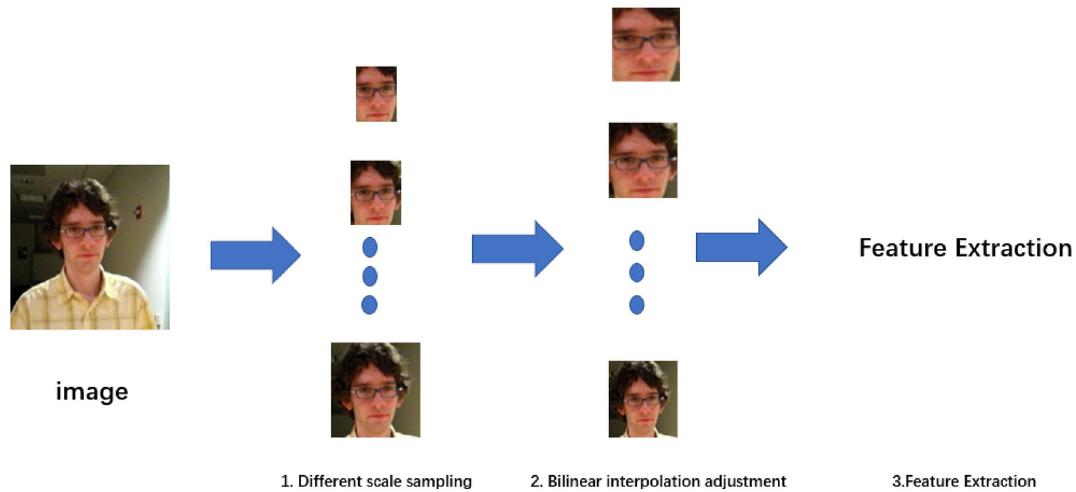
candidate area image blocks to the same dimension as the initial frame template by bilinear interpolation. (3) Perform feature extraction on the candidate ar-ea image